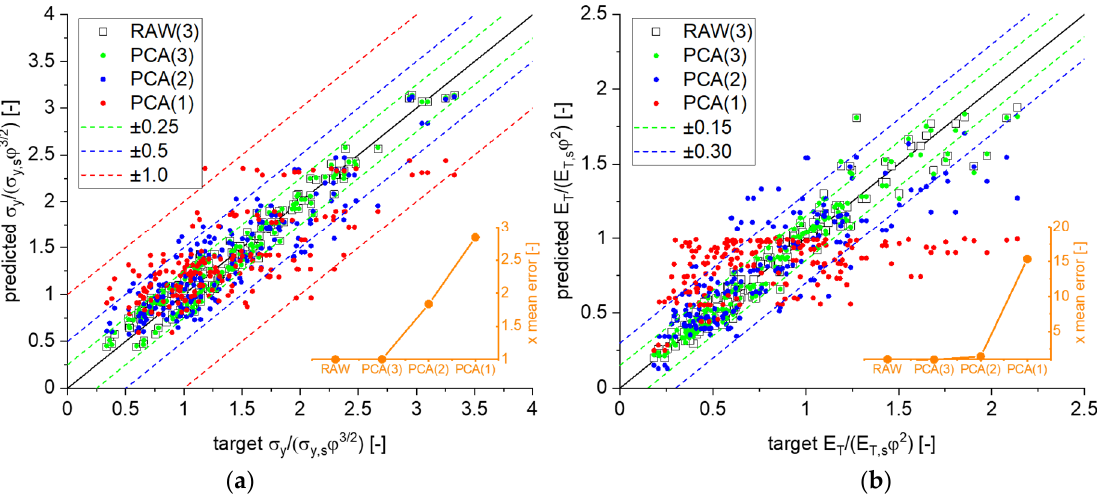
Figure 5. Result of PCA followed by MLP regression with a single hidden layer of 10 neurons for a decreasing number of components: ( a ) scaled yield stress, Equation (14); ( b ) scaled work hardening rate, Equation (15).